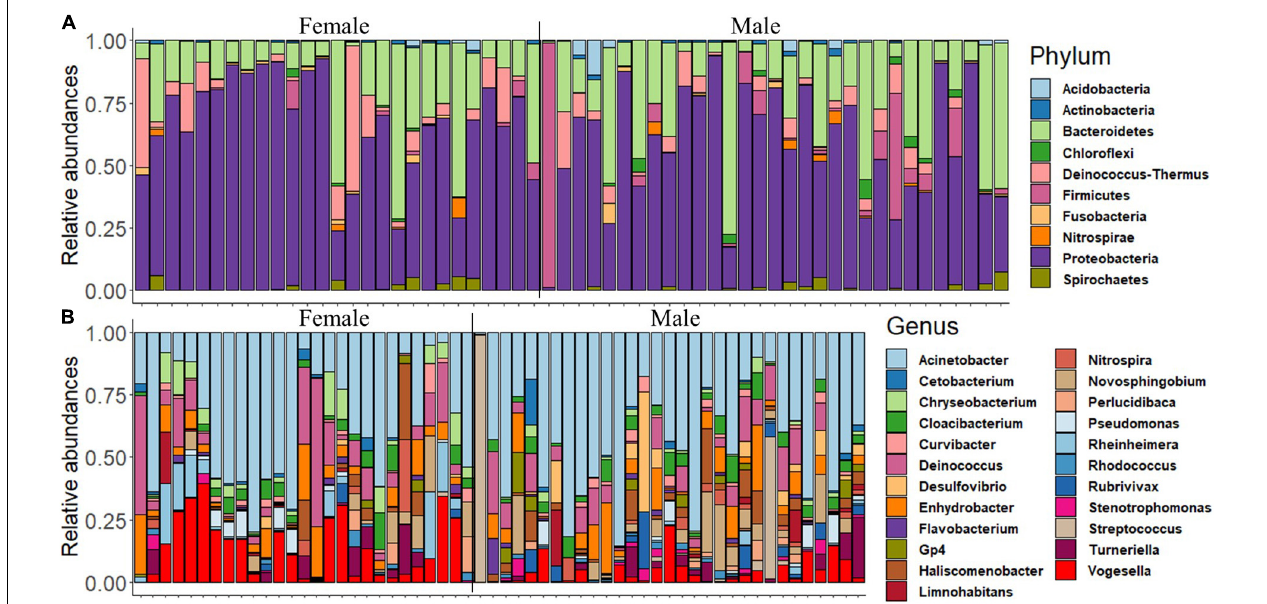
FIGURE 1 | The relative abundance of the microbial composition in the buccal cavity of female and male Nile tilapia. (A) Top 10 dominant phyla. (B) Top 23 dominant genera.